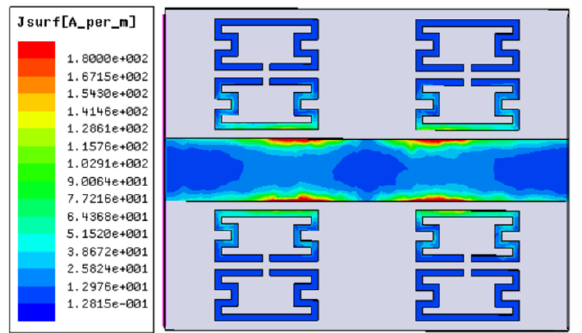
FIGURE. 11.B. THE CURRENT DISTRIBUTION OF MOORE FRACTAL APPLIED SYMMETRICAL RING RESONATOR BANDPASS FILTER AT 7.8 GHZ FREQUENCY IN THE PASSBAND.